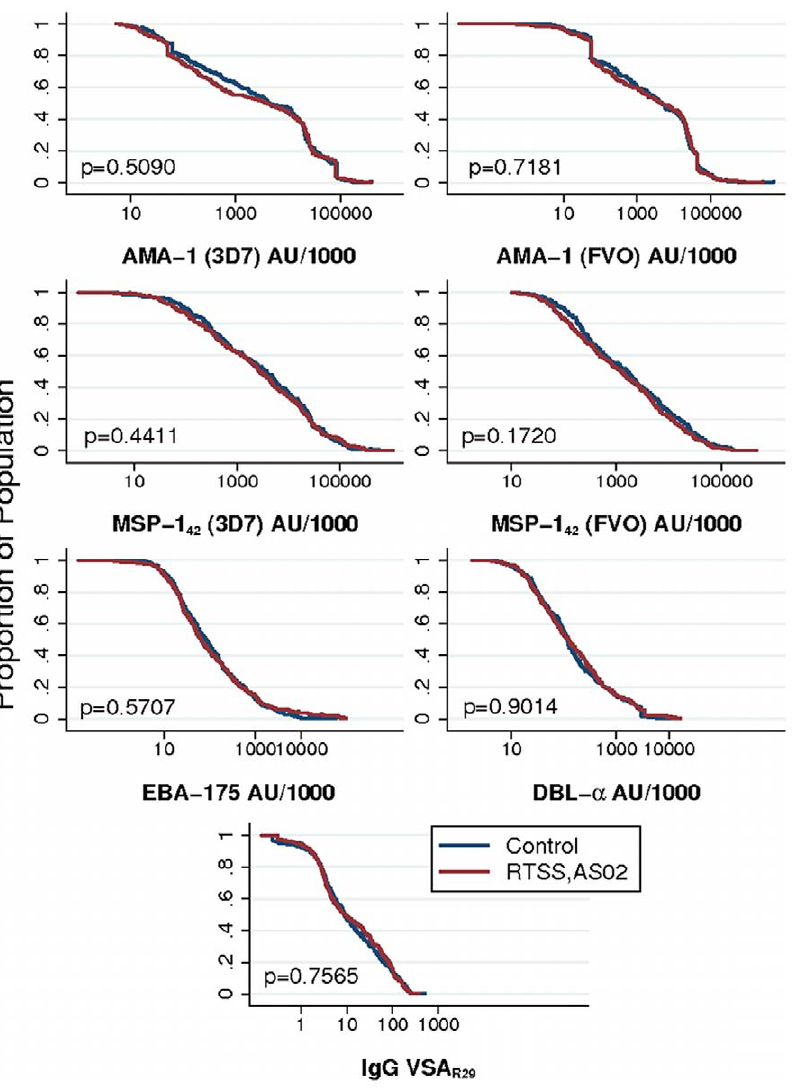
Figure 1. Reverse cumulative distribution of crude IgG responses by treatment group. The graphs represent the pooled antibody responses of children 1–4 years (cohorts 1 & 2 together) who received RTS,S/AS02 vaccine or control vaccine.